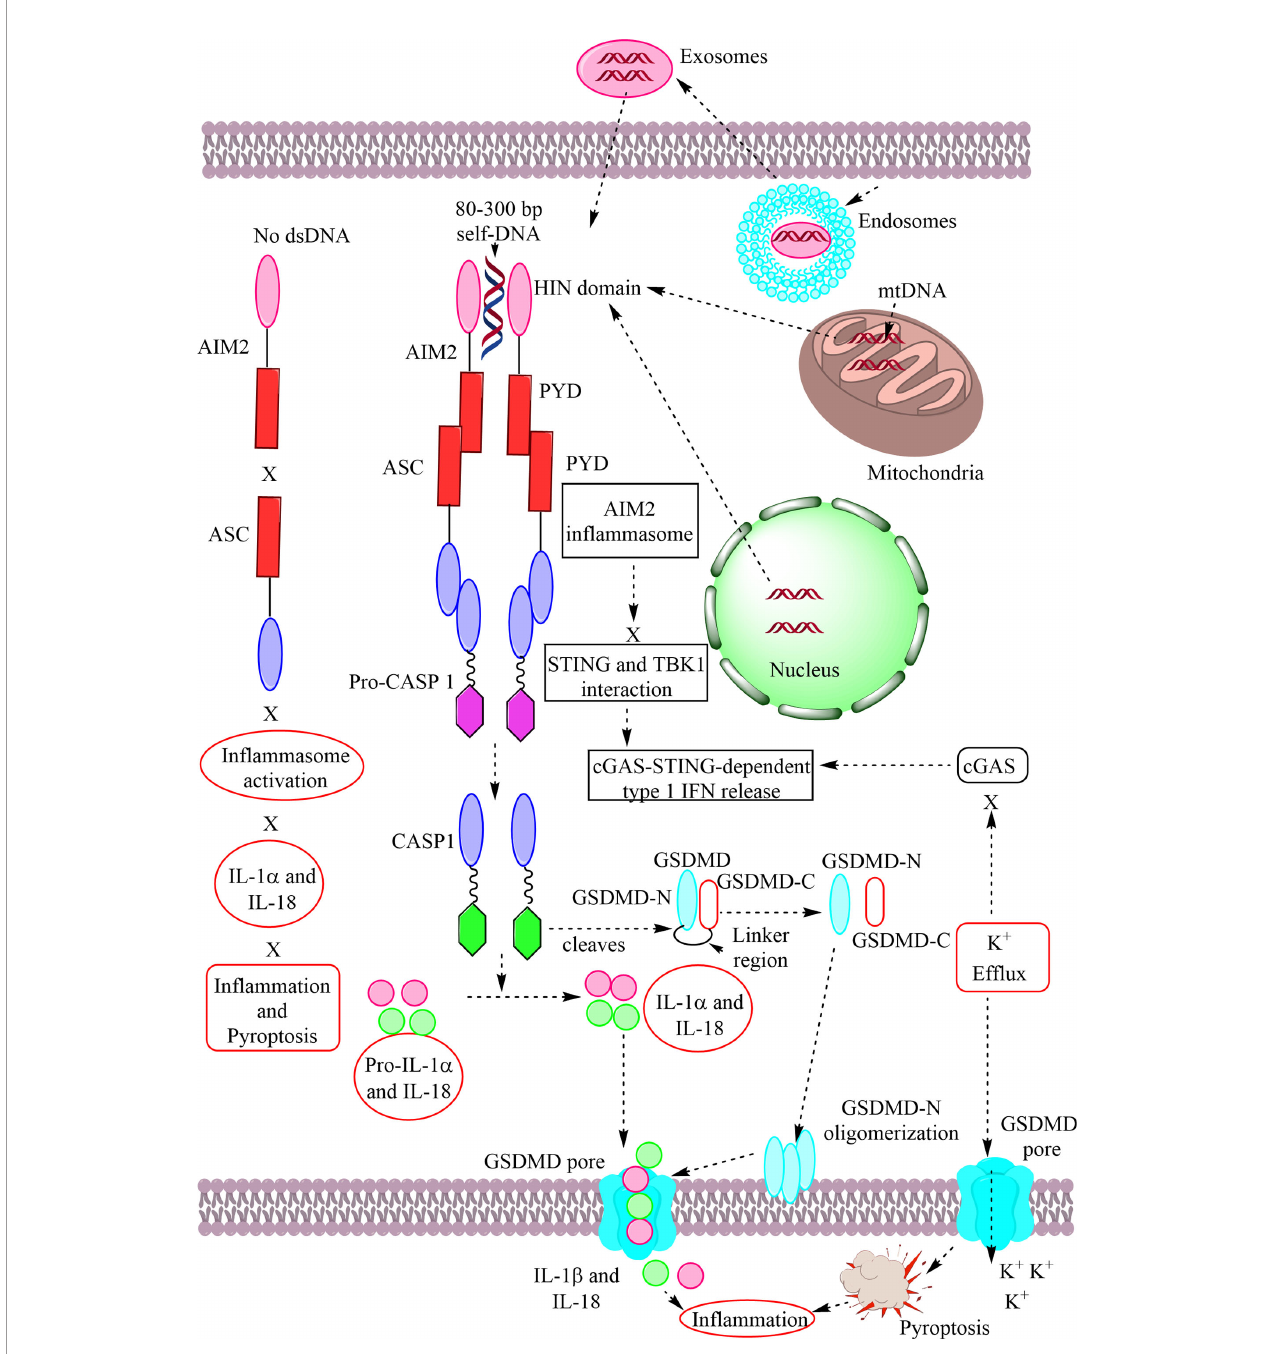
FIGURE 2 | Schematic representation of AIM2 in response to self-DNA. AIM2 is an ALR that becomes activated upon recognizing and binding to the self-DNA coming into cytosol due to cellular damage, including mitochondrial and nuclear damage, and exosome with host DNA. AIM2 activates ef fi ciently in response to self- DNA with 80 – 300 bp. The HIN domain of the AIM2 recognizes cytosolic DNA and its PYD interacts with the PYD of the ASC to form in fl ammasome complex that activates procaspase 1 (pro-CASP1) into CASP1. The CASP 1 cleaves pro-IL-1 a and -IL-18 into IL-1 a and IL-18. CASP1 also cleaves the linker region of the GSDMD and frees GSDMD domains (GSDMD-N and GSDMD-C). The free GSDMD-N terminals interacts with phosphoinositides or other acidic lipids to oligomerize and form GSDMD pore. The GSDMD pore mediates the IL-1 a and IL-18 release from the cells. Also, the K + ef fl ux from the GSDMD pore inhibits cGAS activity and the cGAS-STING mediated type 1 IFN release along with inducing pyroptosis. The AIM2-induced GSDMD acts as a negative regulator of cGAS-STING-mediated type 1 IFN production. Also, AIM2-ASC in fl ammasome inhibits STING-TBK1 interaction required for IRF3-dependent type 1 IFN release. The AIM2 remains inactive in the absence of speci fi c cytosolic